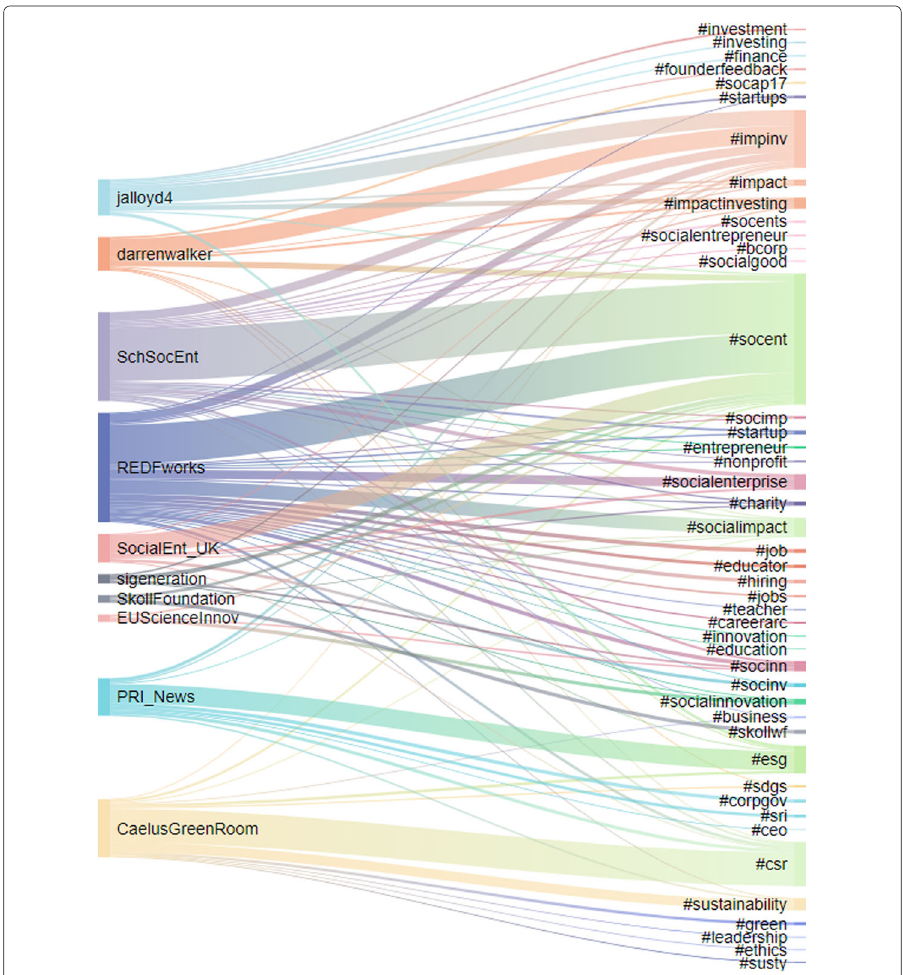
Fig. 5 Mapping of the retweet communities (left-hand side) to hashtags (right-hand side). The retweet communities are identified by the most influential users. Shown are hashtags used at least 1000 times